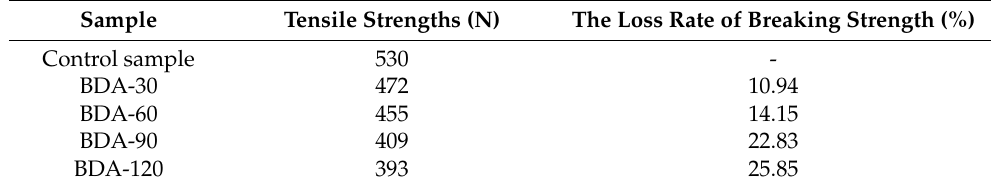
Table 6. The tensile strength of control sample and BDA treated samples (3 curing times, 50 LCs). Sample